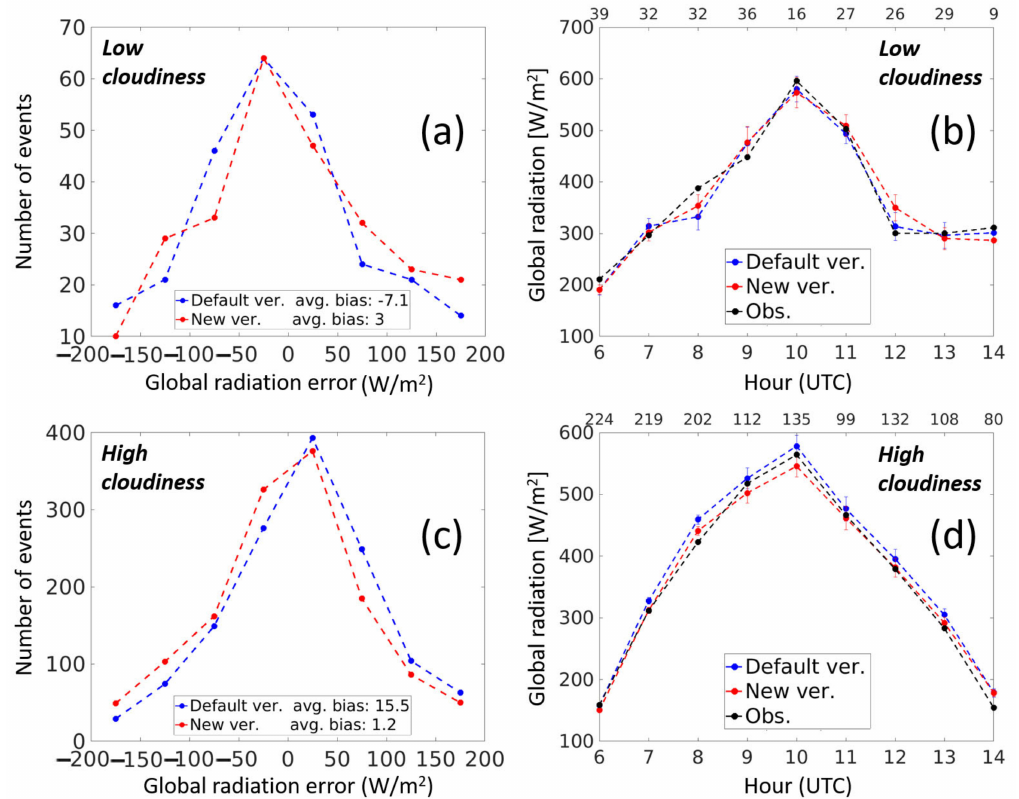
Figure 9. Hourly global radiation verification for low cloudiness ( a , b ) and high cloudiness ( c , d ) during the period July– November 2019. Panels ( a , c ) show the distribution of the bias (model minus observation). Panels ( b , d ) show the mean diurnal cycle of the global radiation in both observations (black), the default COSMO RG92 version (blue), and the new version (red). During the verification period, each of the COSMO versions was simulated twice a day with 78 hours lead-time and verified against 17 automatic radiation stations over